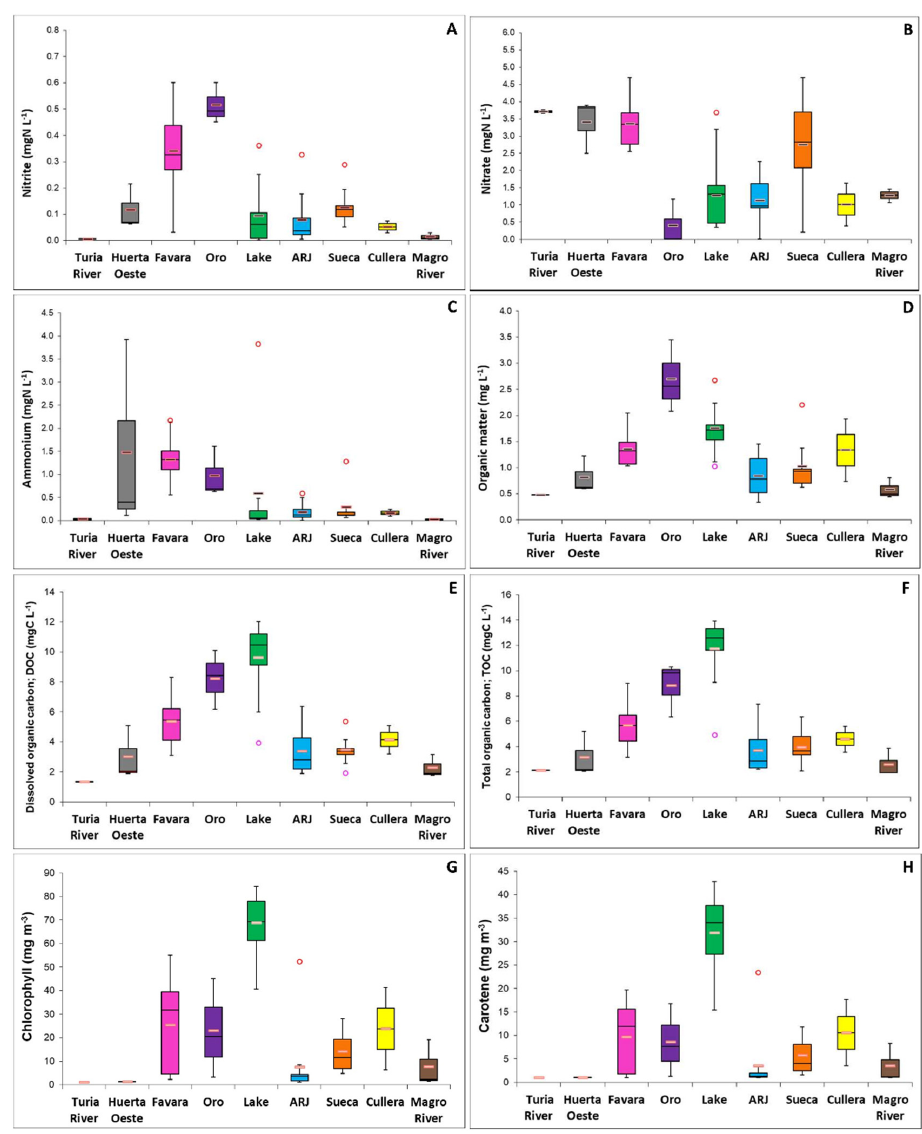
Figure 4. Some of the variables that showed statistical differences between the studied zones (Krus- kal–Wallis test, p < 0.05). Box-plots with medians, percentiles and outlier values. ( A ) Nitrite, ( B ) nitrate, ( C ) ammonium, ( D ) organic matter, ( E ) dissolved organic carbon, ( F ) total organic carbon, ( G ) chlorophyll a , ( H ) carotene.